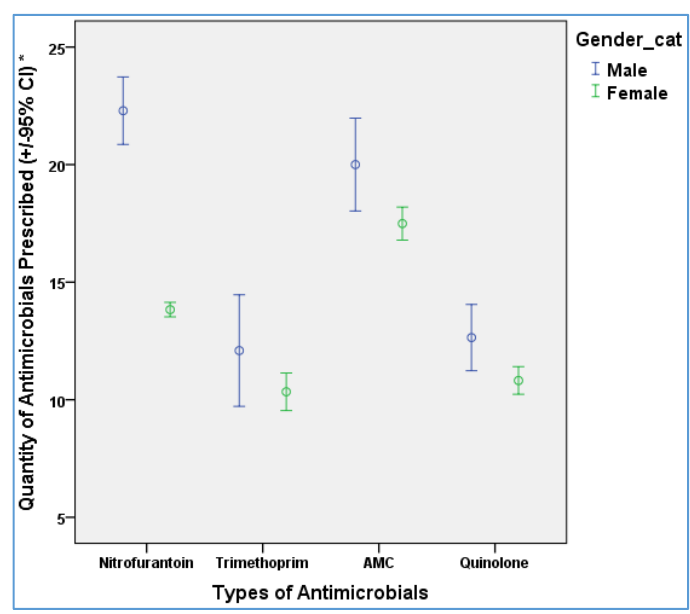
Figure 1. The types of antimicrobial prescribing based on the script quantity by gender. * The quantity of antimicrobial prescribing is measured as the dose dispensed, i.e., number of tablets